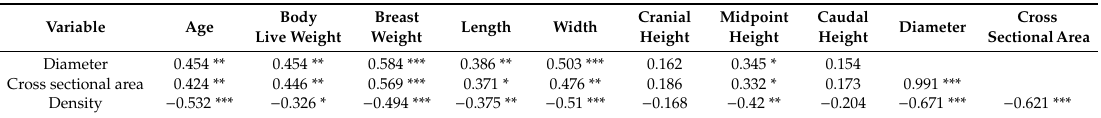
Table 6. Partial correlation coe ffi cients between breast performance and myofiber characteristics for Da-Heng meat type